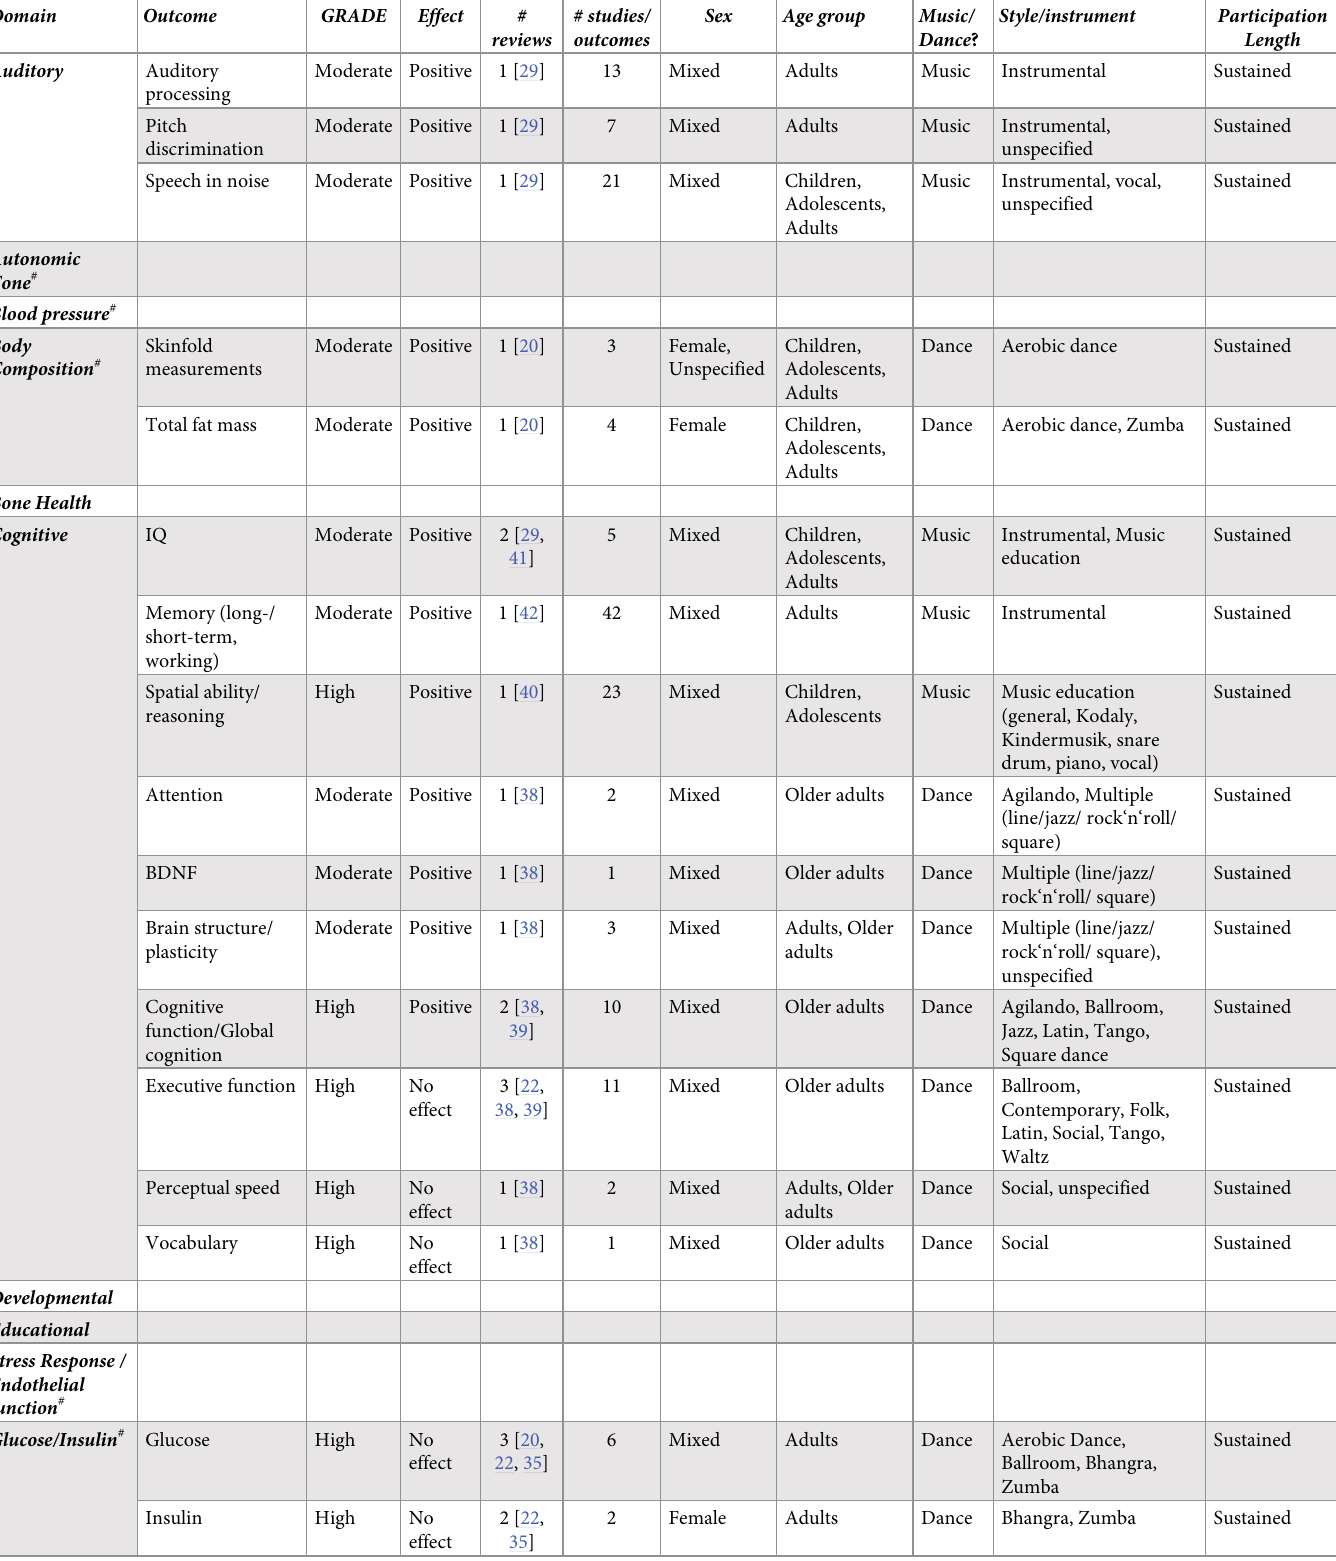
Table 2. Details of specific outcomes with moderate–high quality of evidence